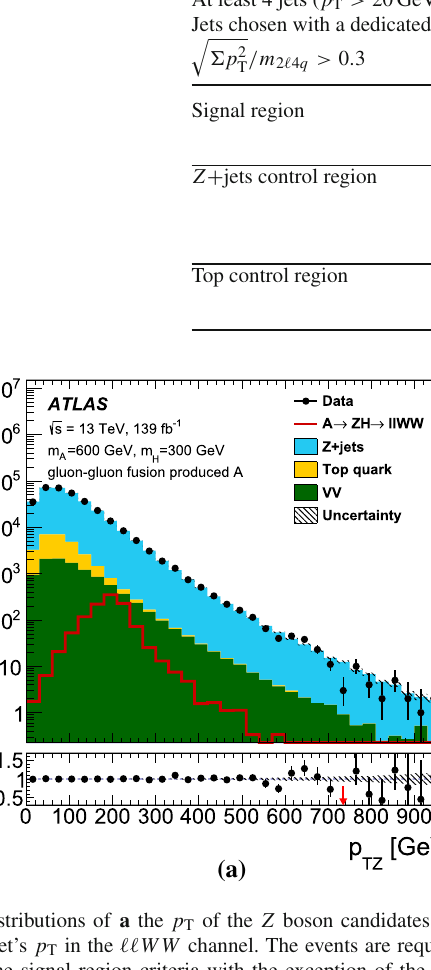
Table 2 Summary of the event selection for signal and control regions in the A → Z H → (cid:6)(cid:6) WW channel